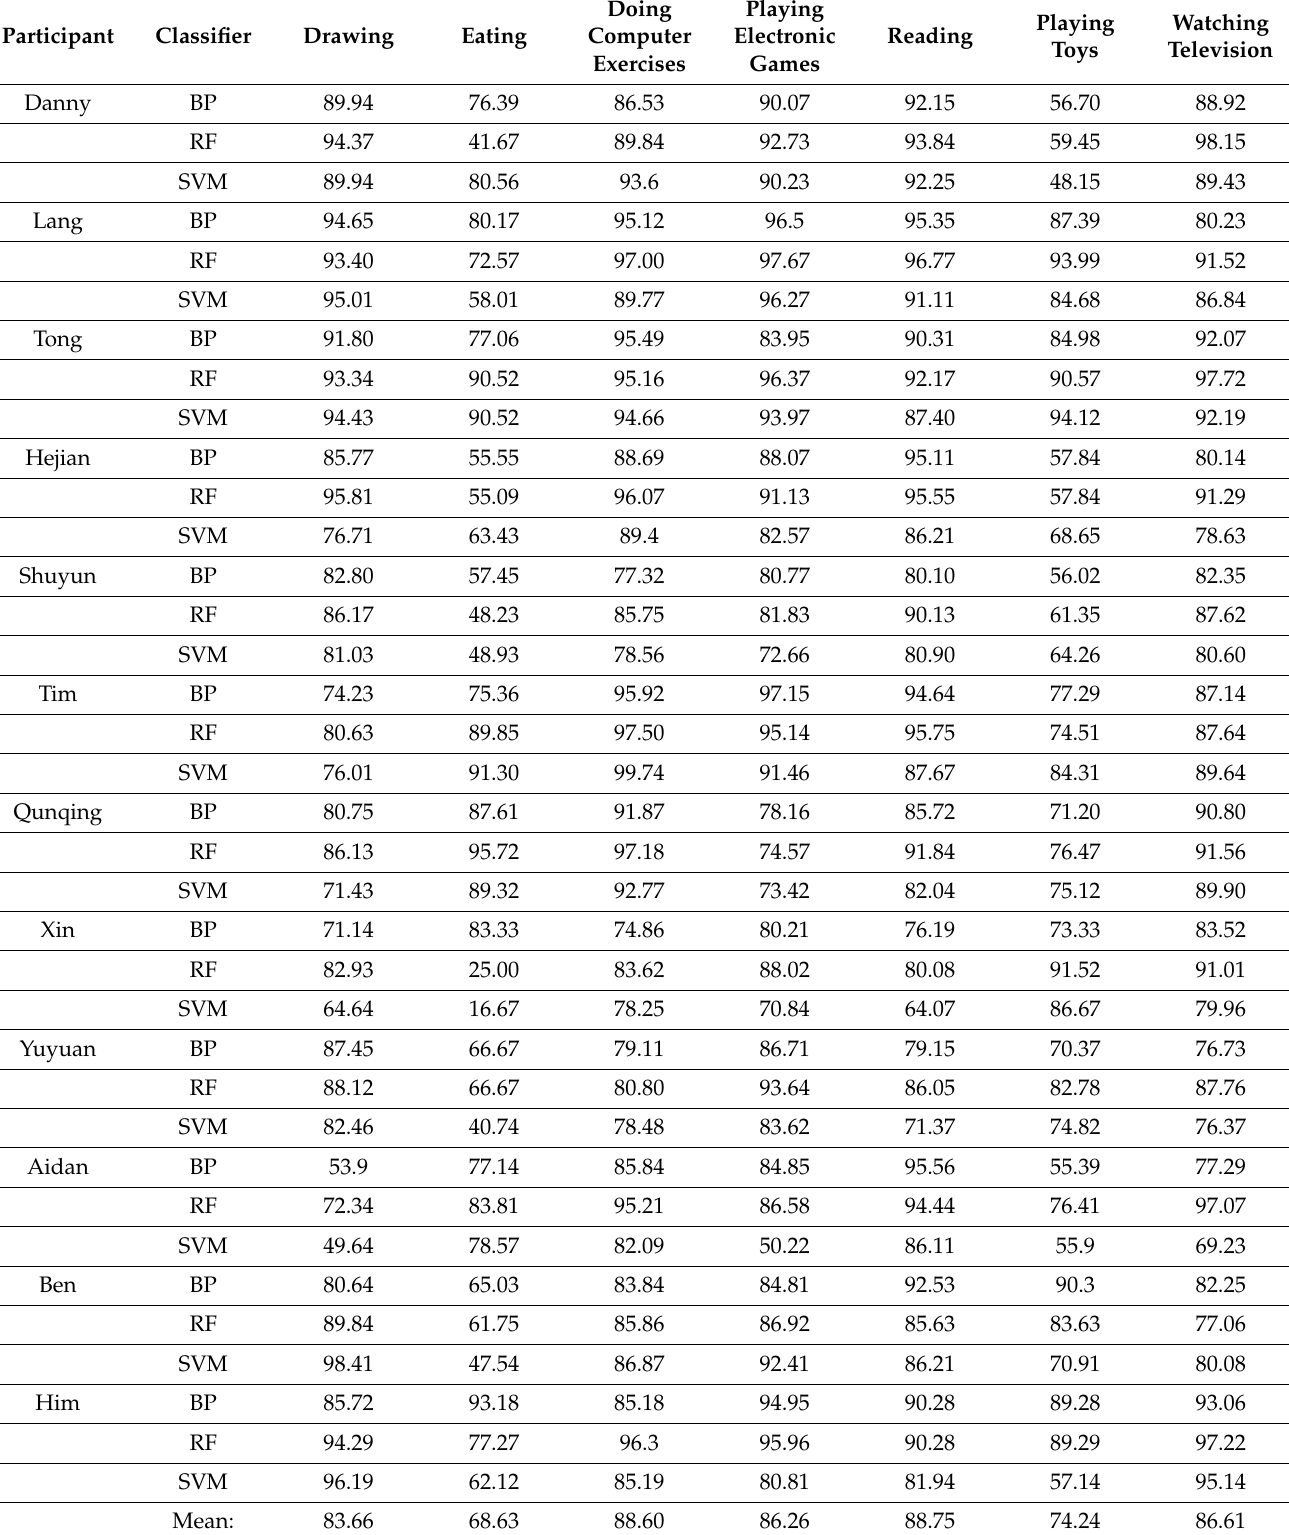
Table 7. The percentages of the classification accuracies for 12 participants performing the various activities under the concentration state yielded by our